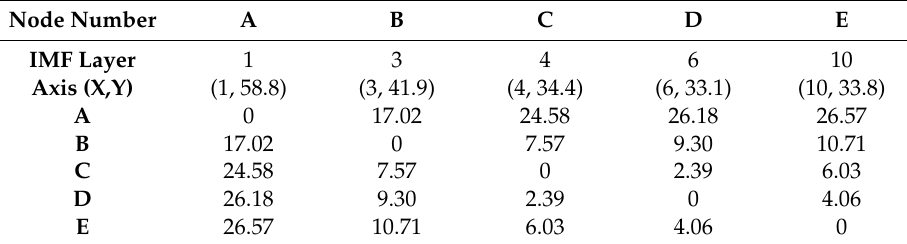
Table 3. The distance between each of the nodes.